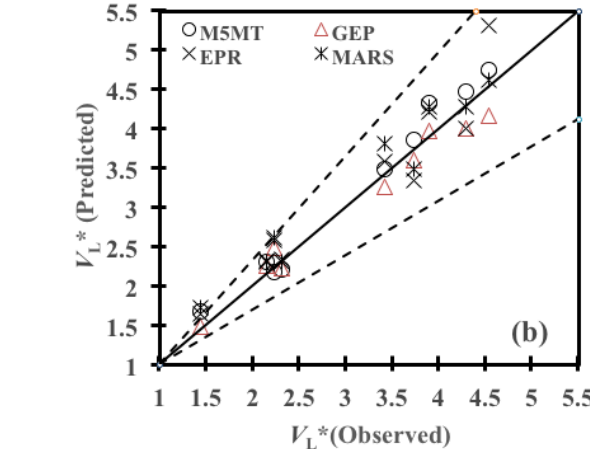
for: ( a ) training and ( b ) testing L